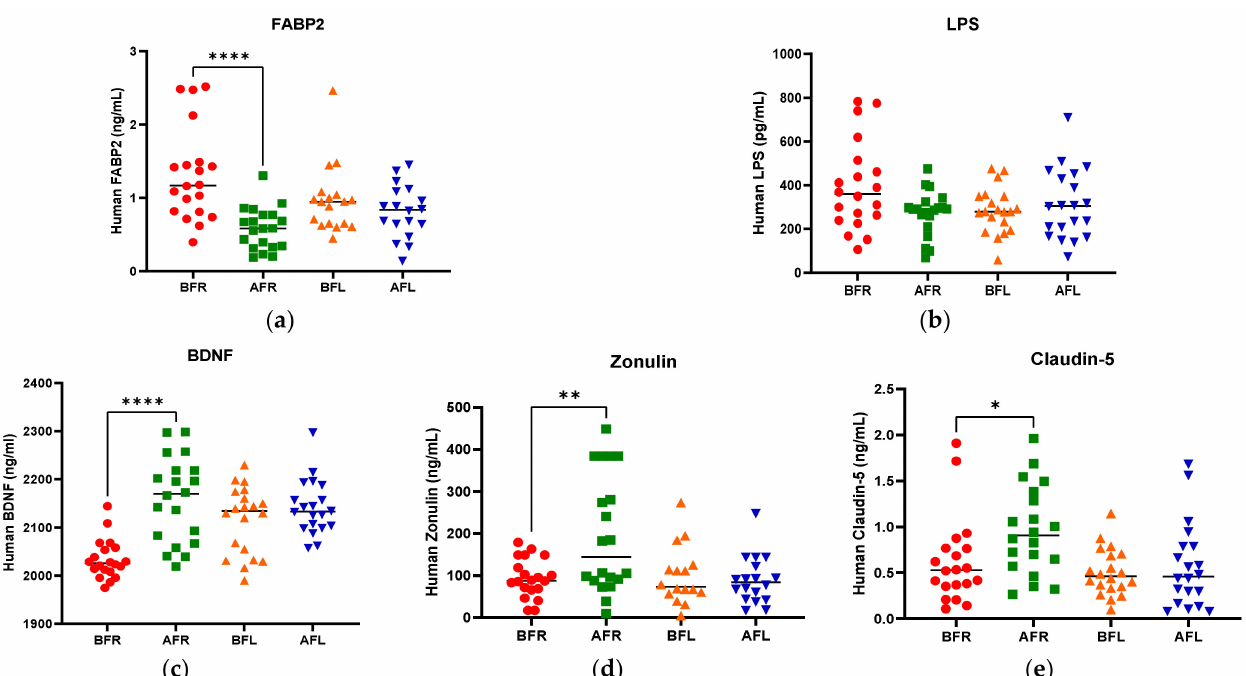
Figure 2. Difference between flavonoid-rich orange juice group or flavonoid-low orange cordial group in plasma levels before and after intervention. ( a ) fatty acid-binding protein-2 (FABP2) ( b ) LPS endotoxin ( c ) BDNF ( d ) Zonulin ( e ) Claudin-5. After 8 weeks of orange juice intervention, the blood markers of human FABP2 in the flavonoid-rich group decreased significantly compared to those of the flavonoid-low groups. In contrast, the BDNF and Zonulin in the flavonoid-rich group were increased significantly compared to those in flavonoid-low groups. BFR: Before flavonoid-rich orange juice group, AFR: after flavonoid-rich orange juice group, BFL: before flavonoid-low orange cordial group, AFL: after flavonoid-low orange cordial group. * p < 0.05; ** p < 0.01; **** p < 0.0001.